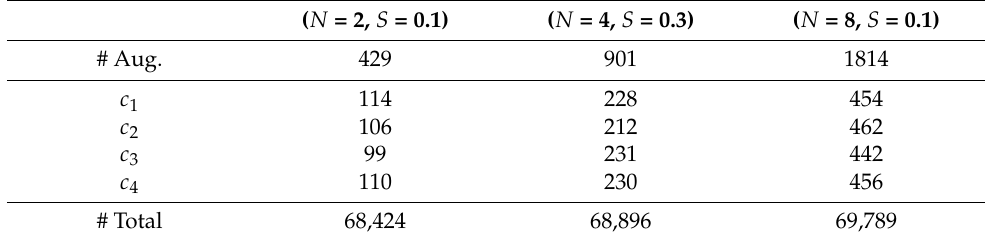
Table A2. Selected model implementation details for TACRED.